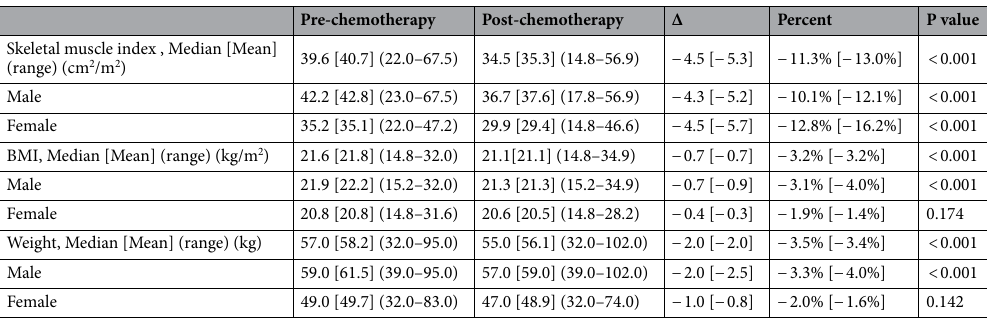
Table 2. Changes in body composition during palliative chemotherapy. BMI body mass index, SD standard deviation.